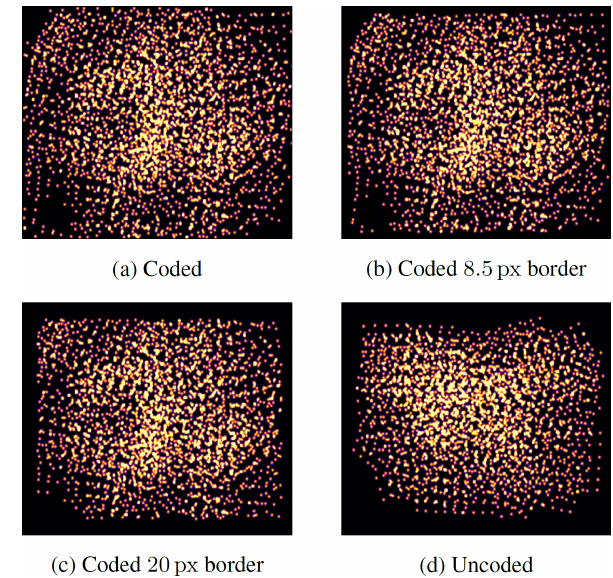
Figure 9. Heat maps of the feature positions for the evaluated vari- ants in Table 2 with N = 50.